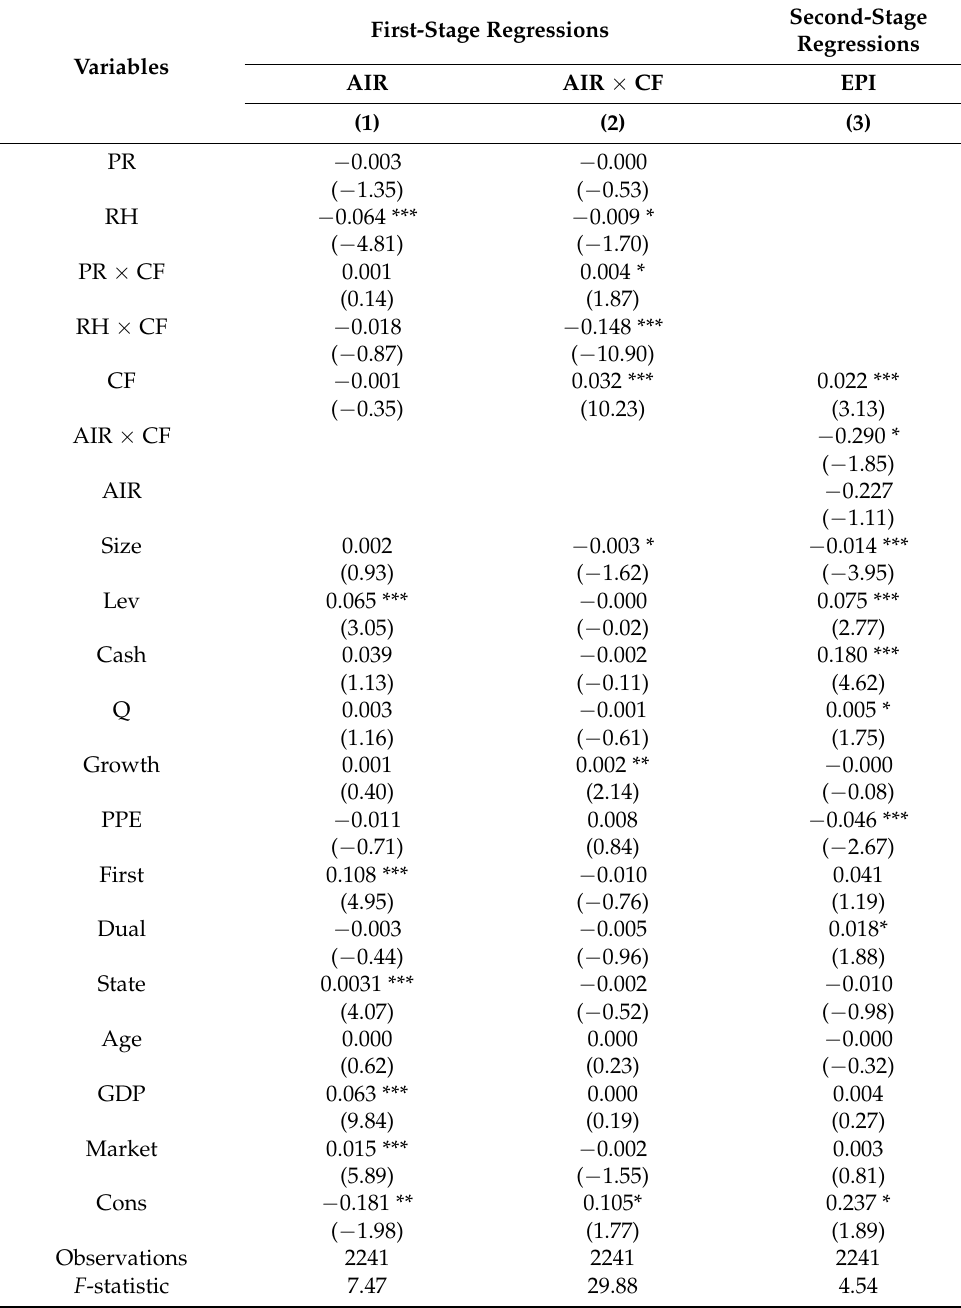
Table 10. Endogeneity test with IV(2SLS)